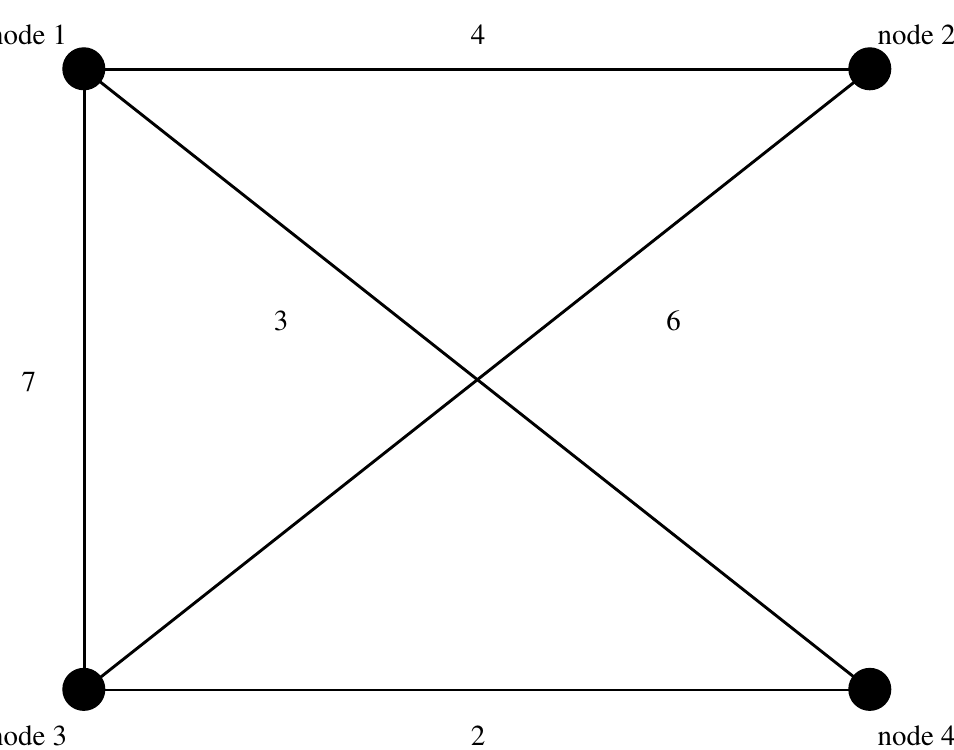
Figure 1. Topology structure of the dynamical network in Example 1 and 3.